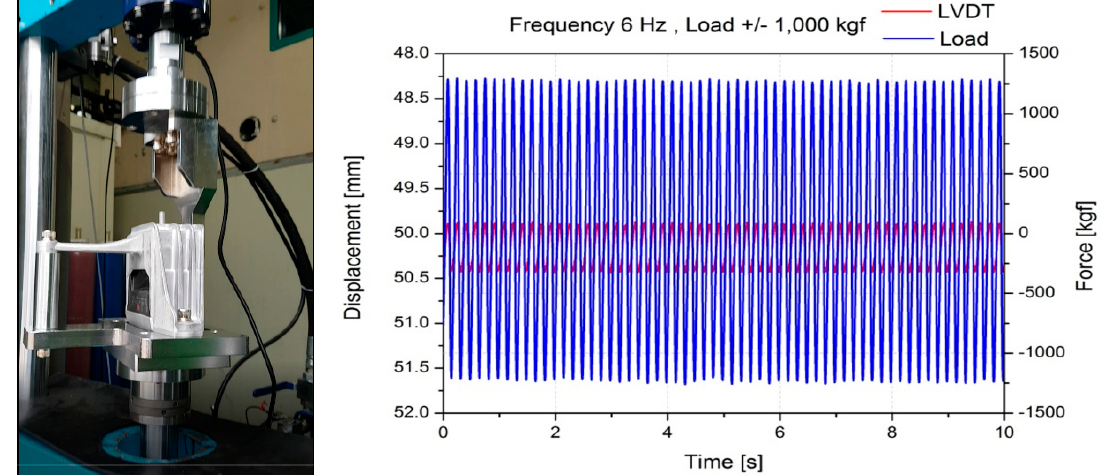
Figure 13. Results of hydraulic servo actuator according to the frequency change of the power control